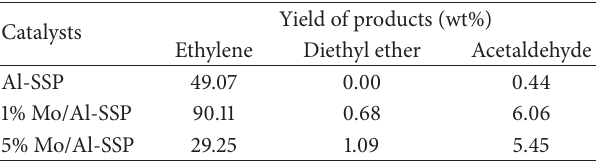
Table 4: Product yield obtained from ethanol dehydration at 300 ∘ C.